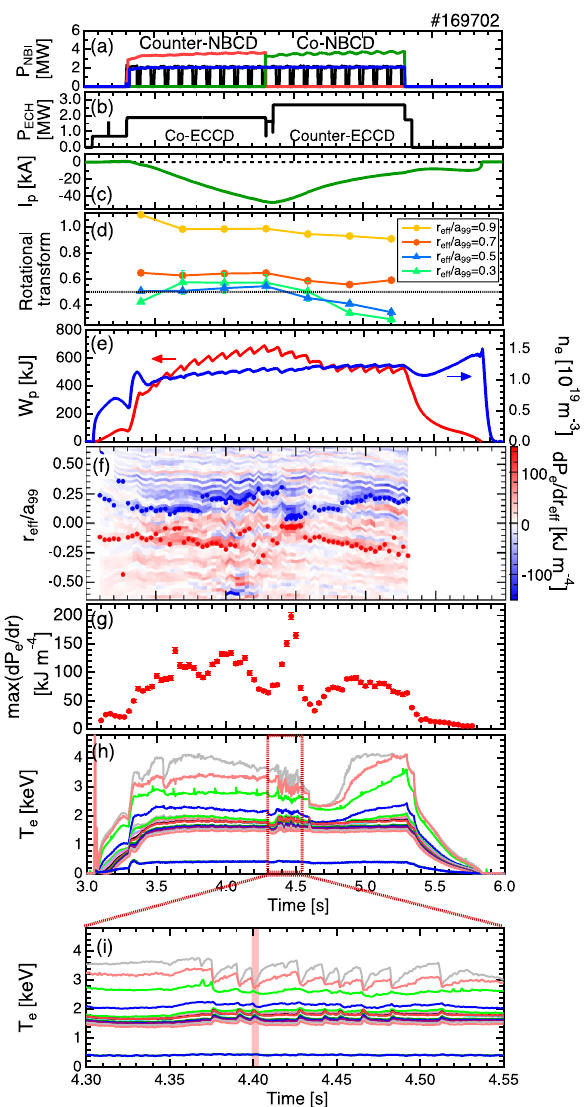
Figure 1. Time evolutions of the ( a ) heating power of the NBI, ( b ) that of the ECRH, ( c ) plasma current, I p , ( d ) rotational transform for each radial position, ( e ) stored energy in the plasma, W p , and line-averaged electron density, ¯ n e , ( f ) profile of the electron pressure gradient, ( g ) maximum value of the electron pressure gradient, ( h ) electron temperature measured by ECE, and ( i ) electron temperature during the minor collapse of the e-ITB. The black horizontal line in Fig. 1d denotes a rotational transform value of 0.5. In Fig. 1f, the radial positions of the maximum pressure gradient are indicated using blue and red